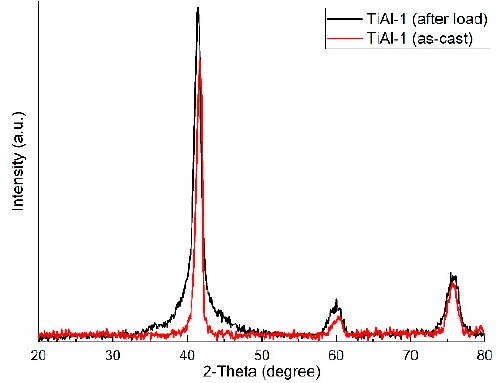
Figure 8. XRD pattern of alloy Al-1 in as-cast and after loading.